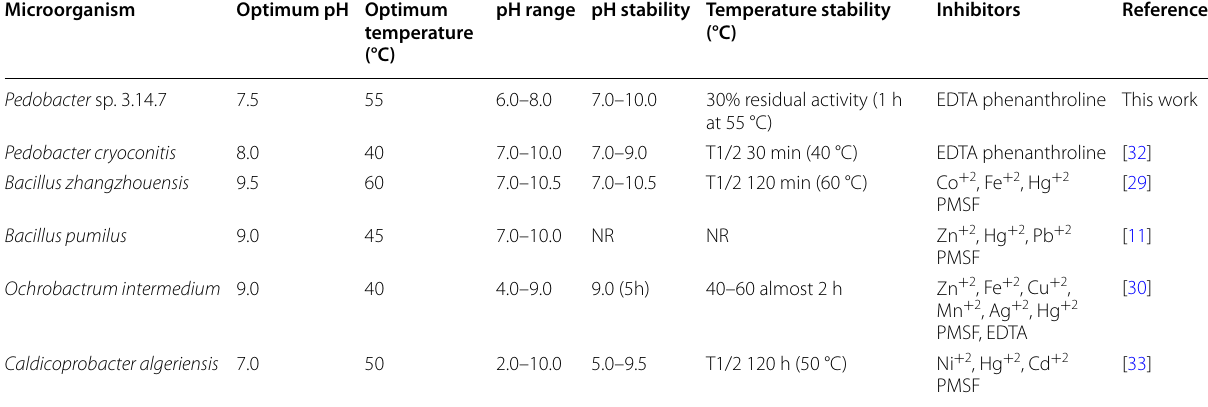
NR not reported, t1/2 half-life of the enzyme, EDTA ethylenediaminetetraacetic acid, PMSF phenylmethylsulphonyl fluoride